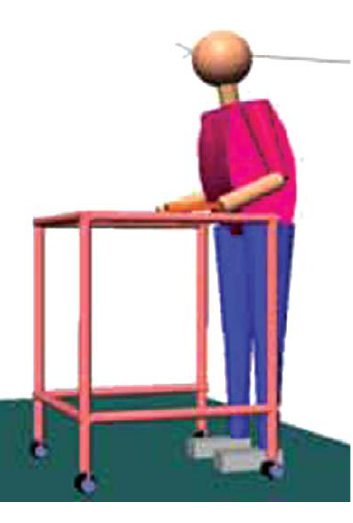
Fig. 1. Humanoid model with wheel